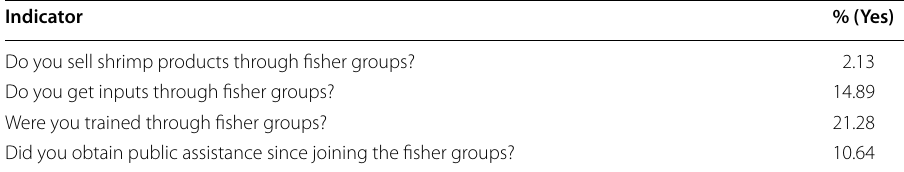
Table 8 Roles of artisanal fisher groups